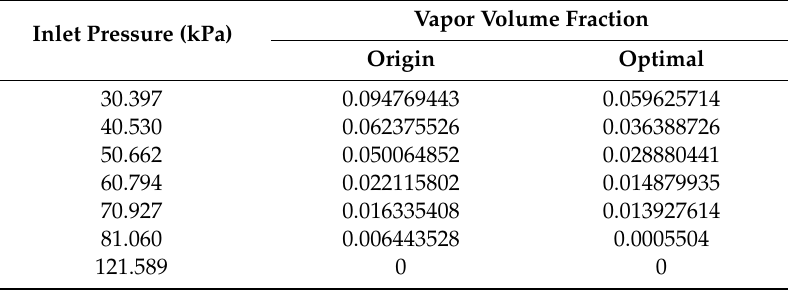
Table 11. Variation in vapor volume fraction.